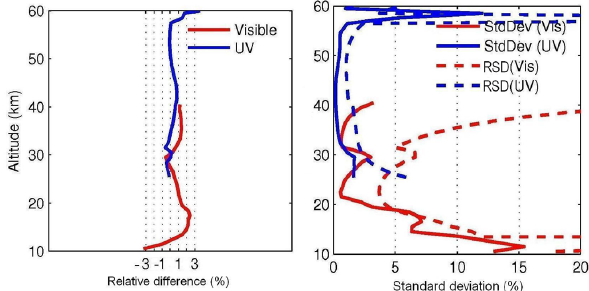
Fig. 6. Summary plot of the relative difference (percent) for all retrieved ozone profiles for the 450 simulated radiances, red is visi- ble, and blue is UV retrievals (left panel). The right panel shows the standard deviation with the same color code. Dashed lines represent the retrieval error or